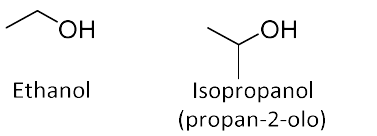
Figure 10. Antimicrobial